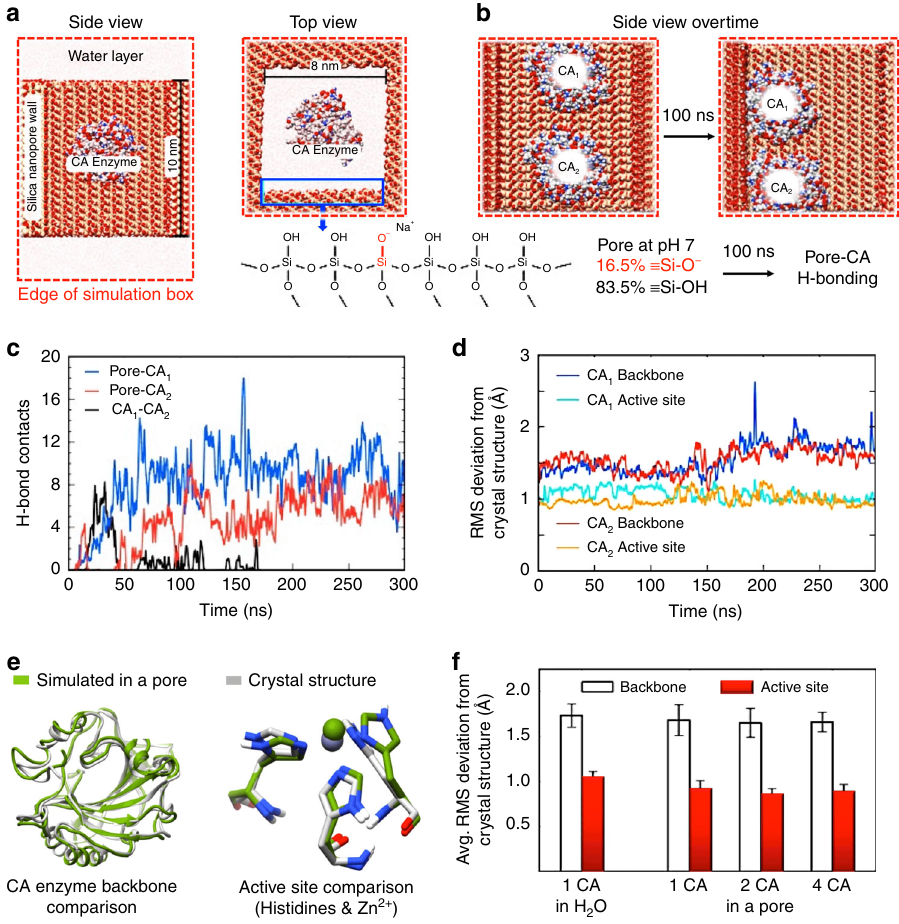
Fig. 8 Molecular dynamics simulations of carbonic anhydrase con fi nement within individual mesopore channels of the enzymatic liquid membrane. a , b Setup for the molecular dynamics simulations of CA enzymes con fi ned within a silica nanopore. c CA enzymes rapidly (<100 ns) adsorb to the surface of the silica nanopore and remain in contact with the pore walls for the duration of the simulation, as shown by H-bond contacts between the pore and CA in c . d Root-mean-squared deviation (RMSD) data of the protein backbone and active site atoms shows that the structure of the CA enzymes adsorbed to the pore remains stable during the course of the simulation and close to the crystal structure. e Ribbon representation (left) and close-up of the active site of the CA enzyme show close similarity between the average structure simulated in the nanopore and crystal structure. f Average RMSD data (over the last 50 ns of 300 ns simulations) for 1, 2, and 4 CA enzymes per pore (to simulate varying crowded conditions) shows that the structure of the enzyme is highly robust and resembles that of the free CA structure in solution. Error bars represent 95% con fi dence intervals for experiments performed with n =